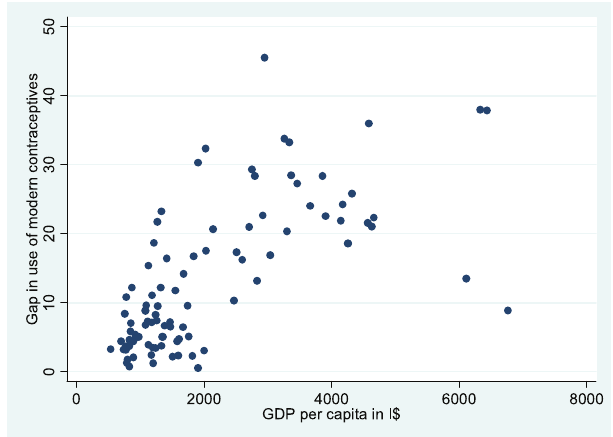
Figure 2. Modern Contraceptive Use and Level of Economic Develop- ment Gaps increase at higher incomes. The gap in modern contraceptive use rates between the national average and the poorest quintile versus GDP per capita in international dollars is shown.